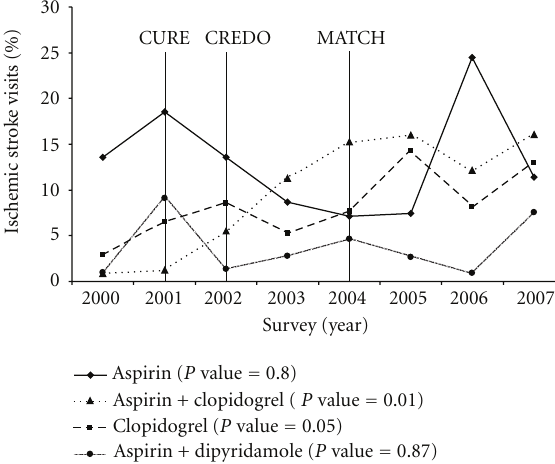
Figure 1: Antiplatelet prescribing trends among patients